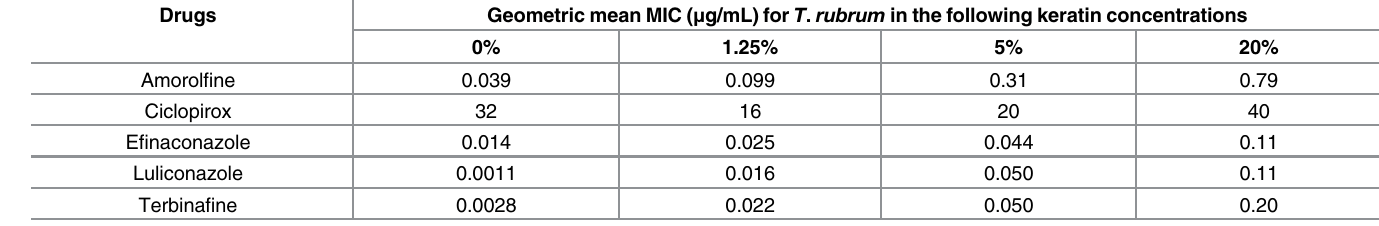
Data represent the geometric mean MIC for 6 T . rubrum